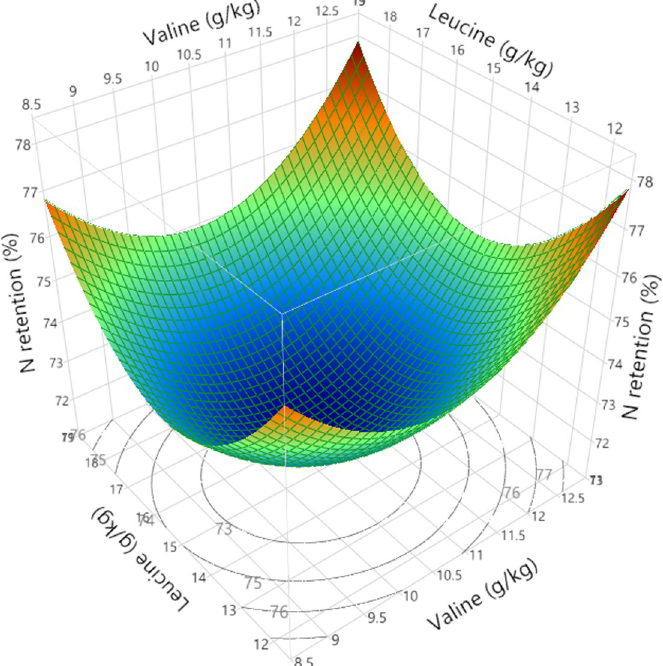
Fig 8. Response surface showing the relationship between dietary digestible leucine (Leu) and valine (Val) on nitrogen (N) retention from 24 to 27 days post-hatch where the lowest N retention was estimated at 15.25 and 10.50 g/kg Leu and Val